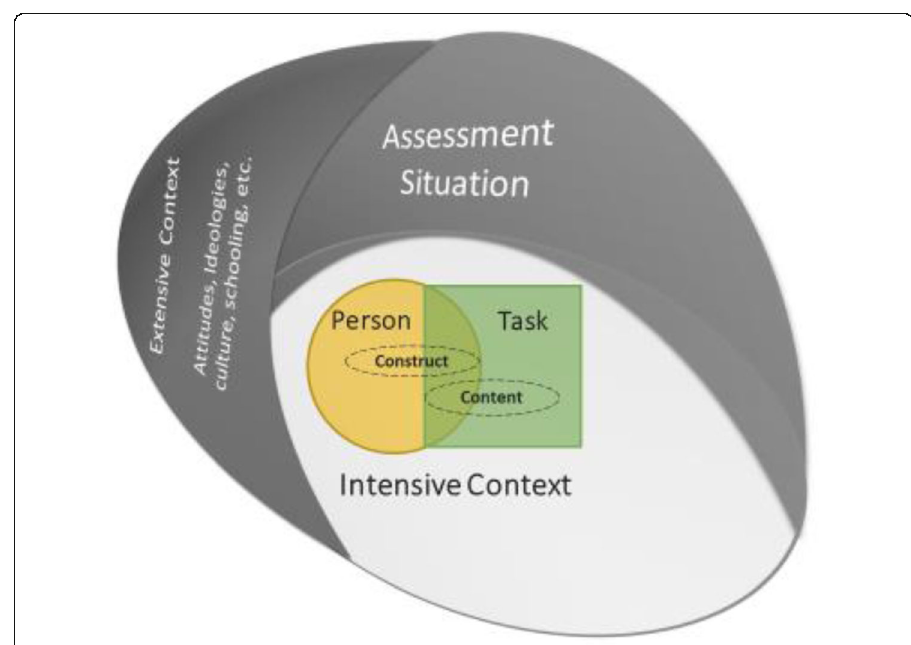
Fig. 2 A representation of context and person × task interaction as depicted in ability-in language user-in